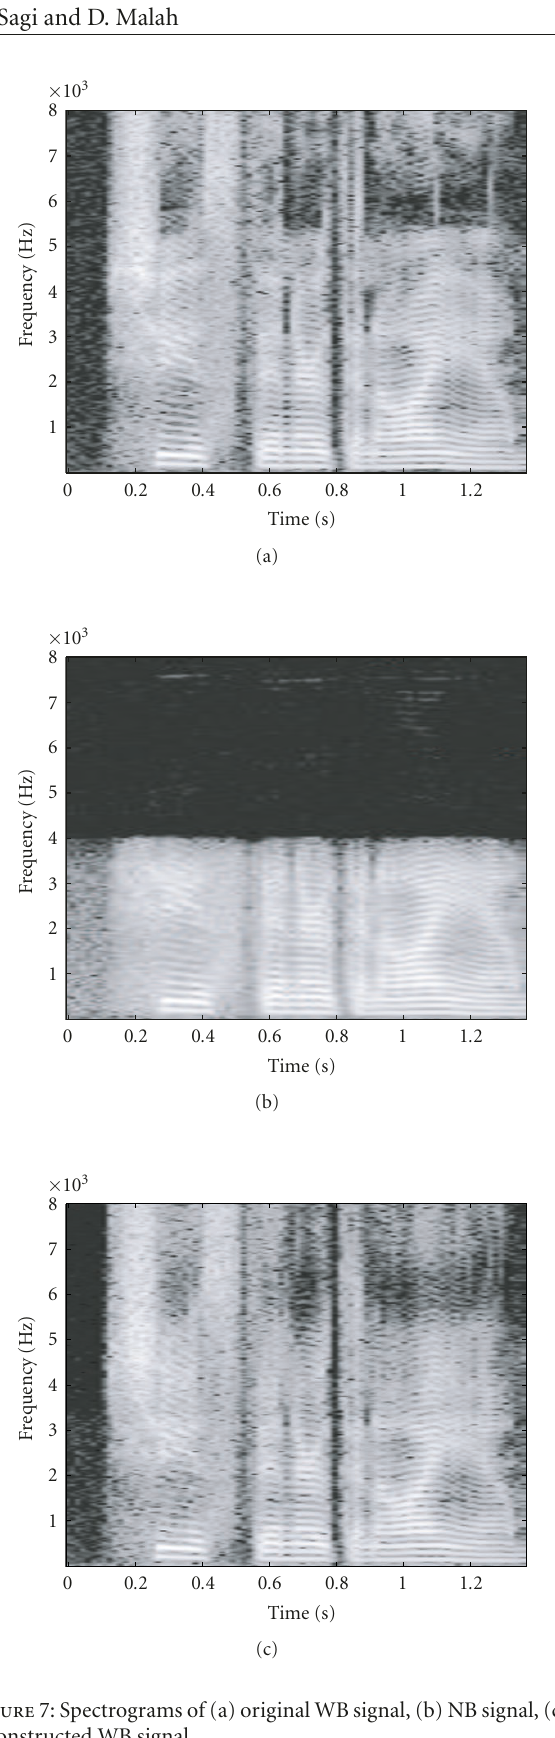
Figure 7: Spectrograms of (a) original WB signal, (b) NB signal, (c) reconstructed WB signal.